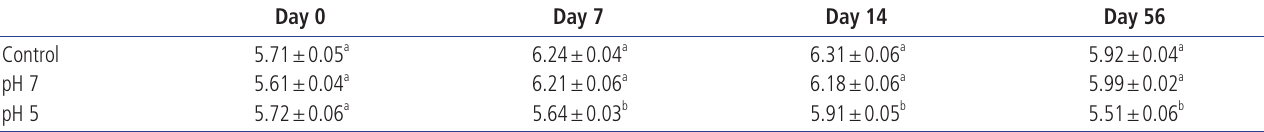
The values are mean±standard deviation of four replicates. a,b Different letters in horizontal row indicate significantly different at p<0.05 according to the Duncan’s multiple range test.